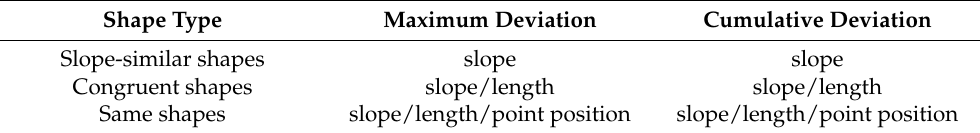
Table 3. Similarity metrics for different types of shapes.